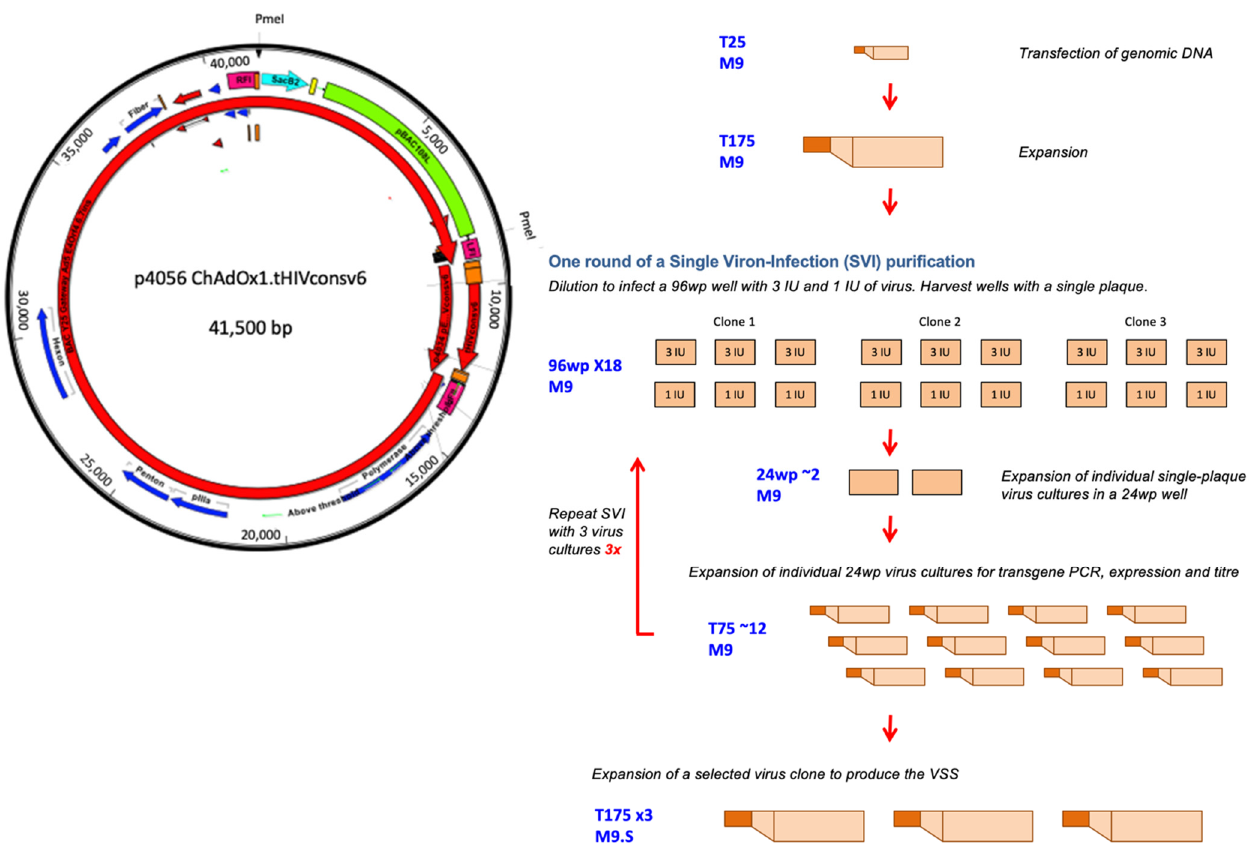
Figure 1. Preparation of the virus seed stock. ( Left ) Schematic map of BAC p4056. The dsDNA ChAdOx1.tHIVconsv6 genome was excised from BAC p4056 using the PmeI restriction endonuclease. ( Right ) The VSS preparation started transfection of the genome into M9 cells in T25, and the whole cell culture harvest was amplified in T175. The resulting virus preparation was titred and tested by ID, flank-to-flank and purity PCRs, as well as for transgene product expression using Western blot of infected cell lysates assessed for Gag p24-specific mAb reactivity and size. The first round of SVI purification started by infection of 96wp cultures with an average of either 3 or 1 IU per well. The cell monolayers were inspected regularly over the following week, and only wells with a single visible plaque were collected and expanded first in 24wp wells and then in T75 to make enough virus for titration, PCR and expression testing. Three virus clones were taken into the next round of SVI. After SVI-3, the best growing/expressing clone was expanded in three T175 flasks of M9.S cells to generate the VSS, which served as the GMP starting material.